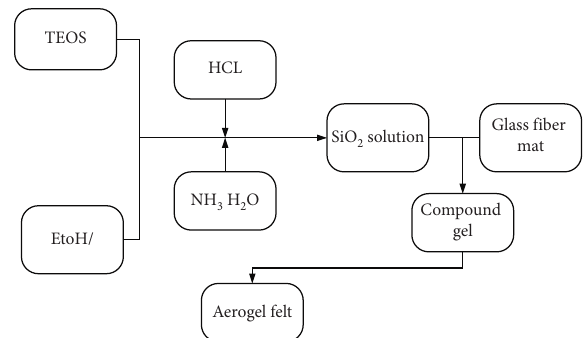
Figure 1: Process flow of aerogel wall insulation material preparation at atmospheric pressure.